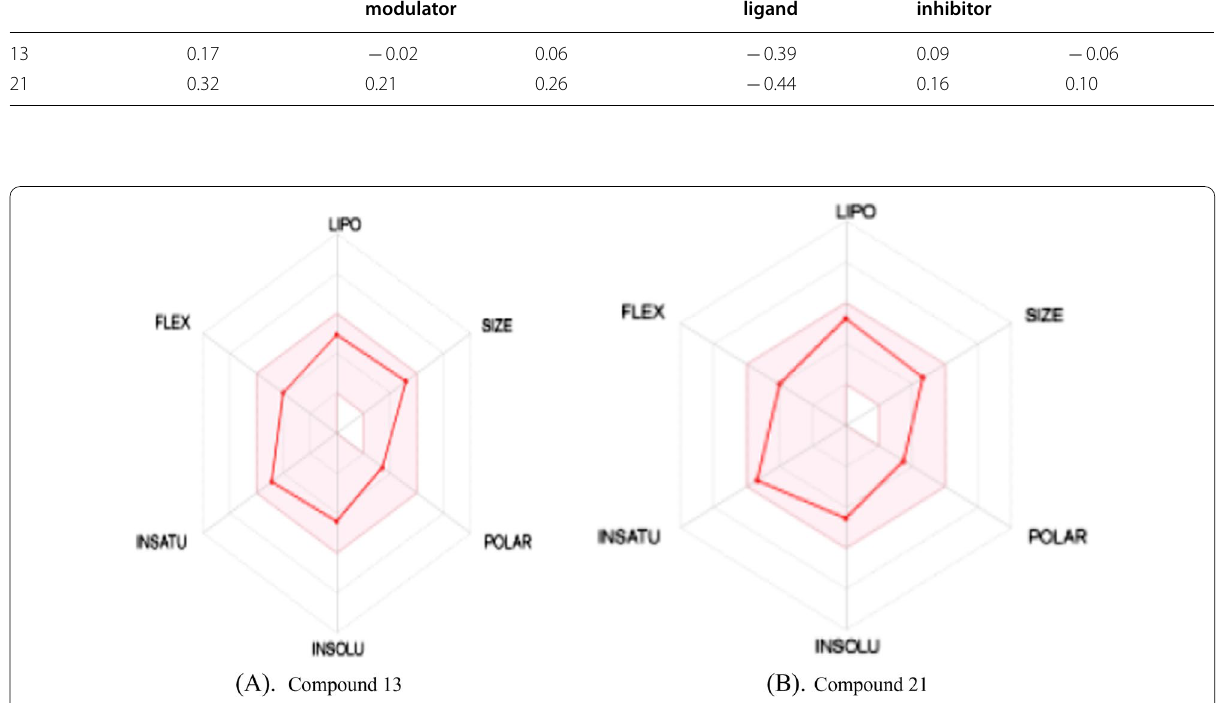
Table 12 Bioactivity score of the compounds Compounds